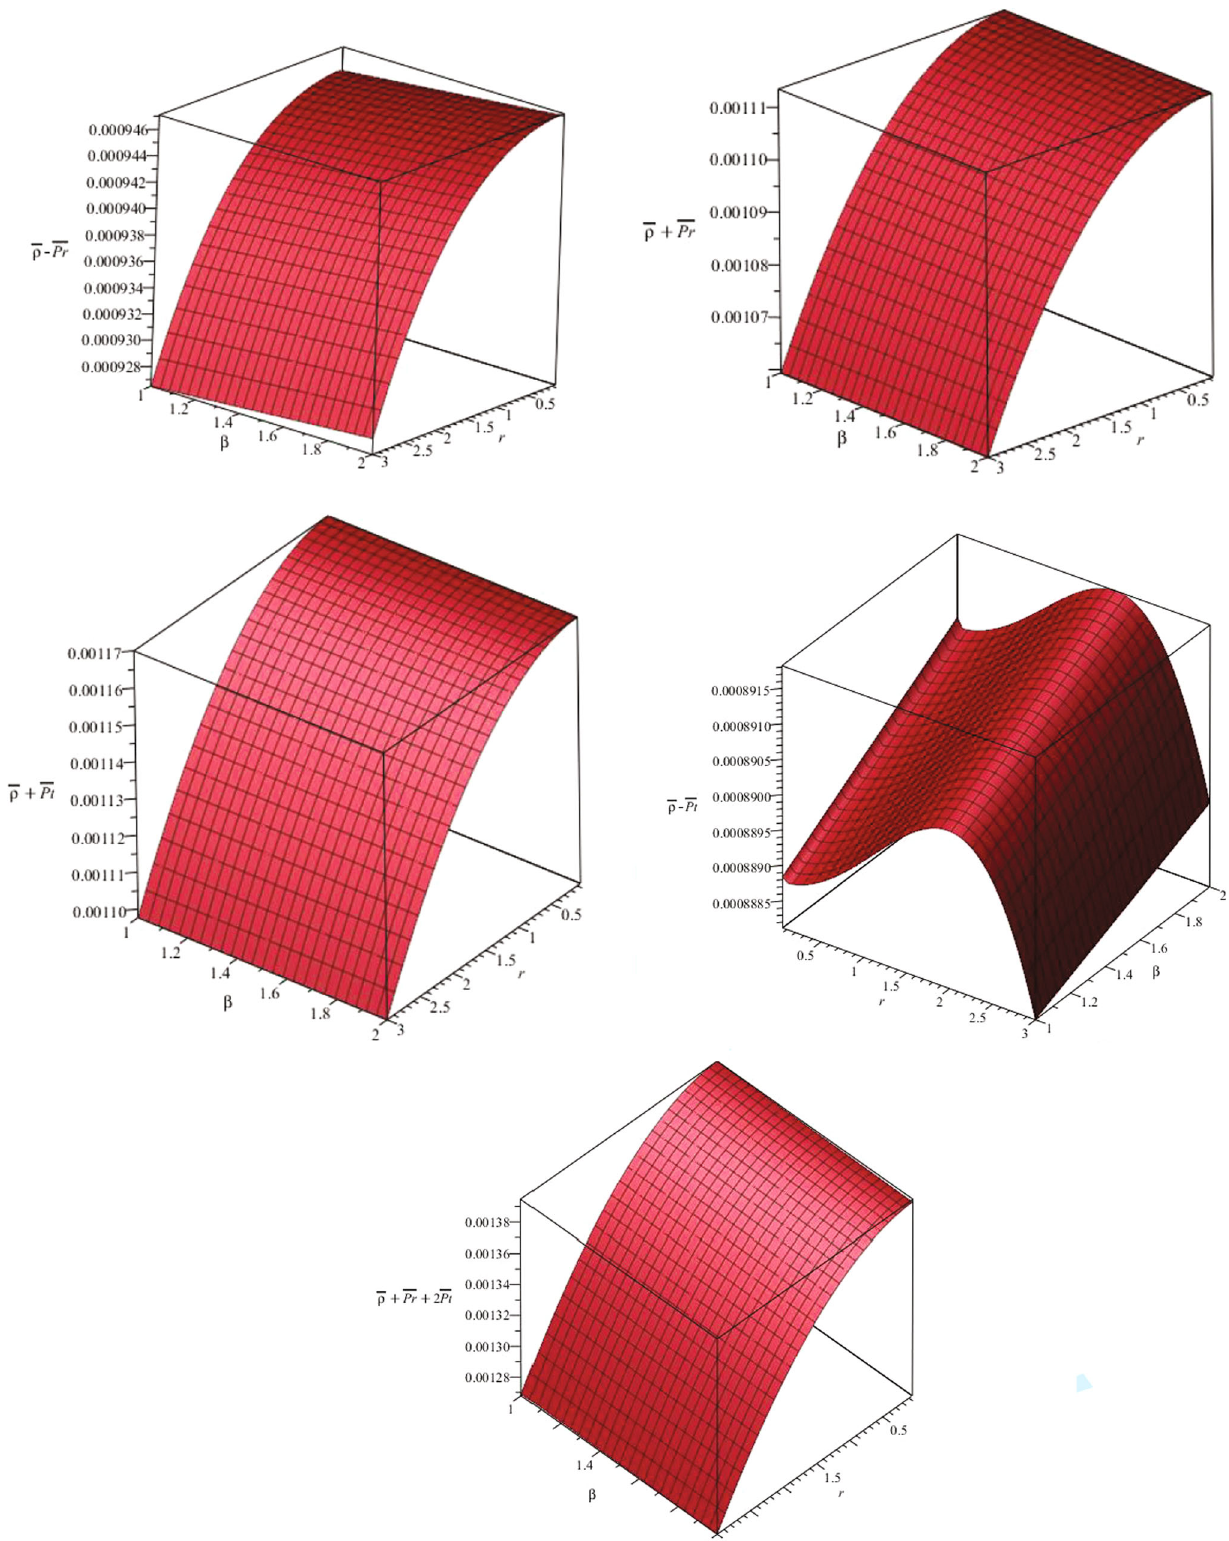
Fig. 2 Plots of energy conditions against r and β using M 0 = 1 M (cid:9) and R = ( 0 . 2 ) − 1 M (cid:9) for